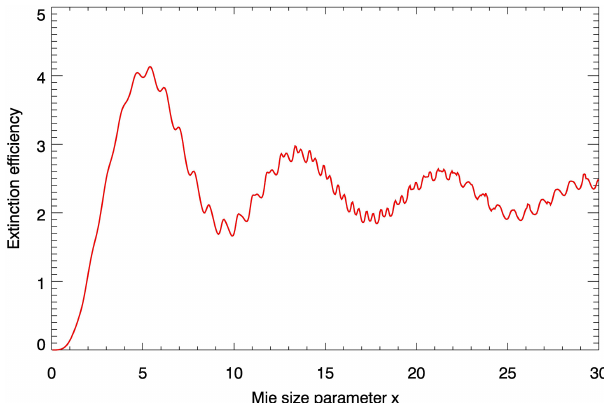
Figure 2. Dependence of the extinction efficiency on the Mie size parameter for monodisperse spherical particles with a refractive in- dex (real part) of 1.4. For x ranges with a negative slope, a blue sun may